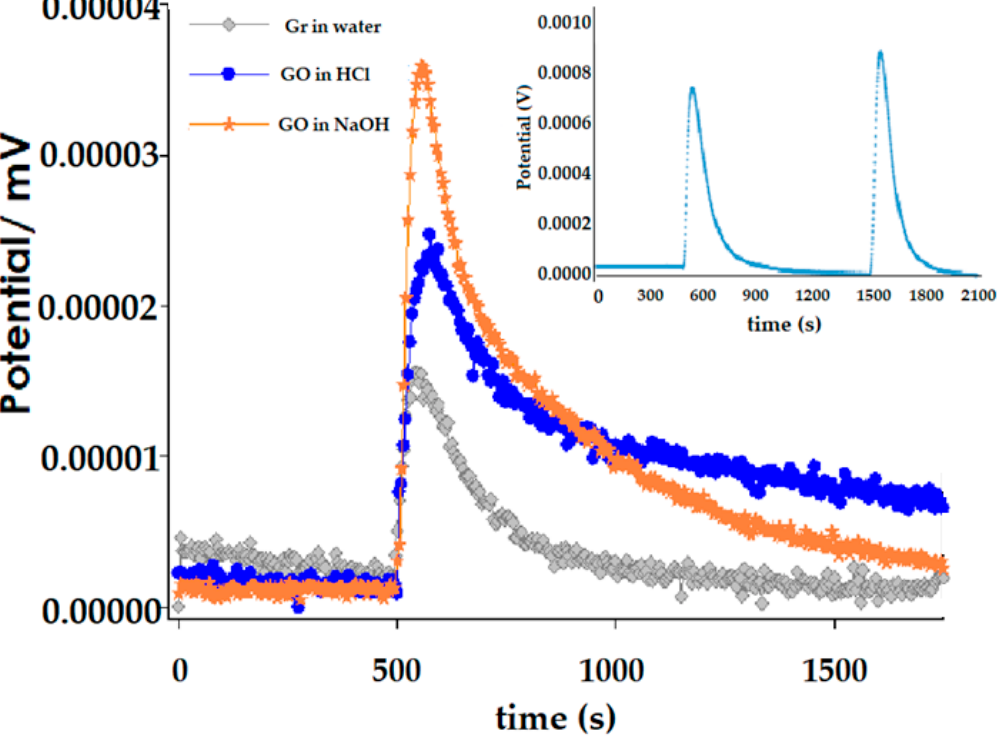
Figure 3. Immersion thermograms of Gr and GO: ( gray line ) Gr in water, ( blue line ) GO in HCl and ( orange line ) GO in NaOH. In the internal box a typical thermogram.